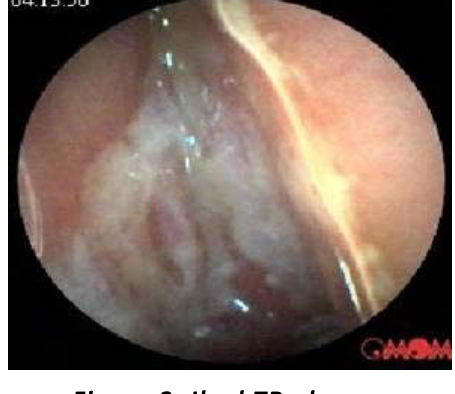
Figure 1: Hookworm sucking blood Figure 2: Ileal TB ulcer